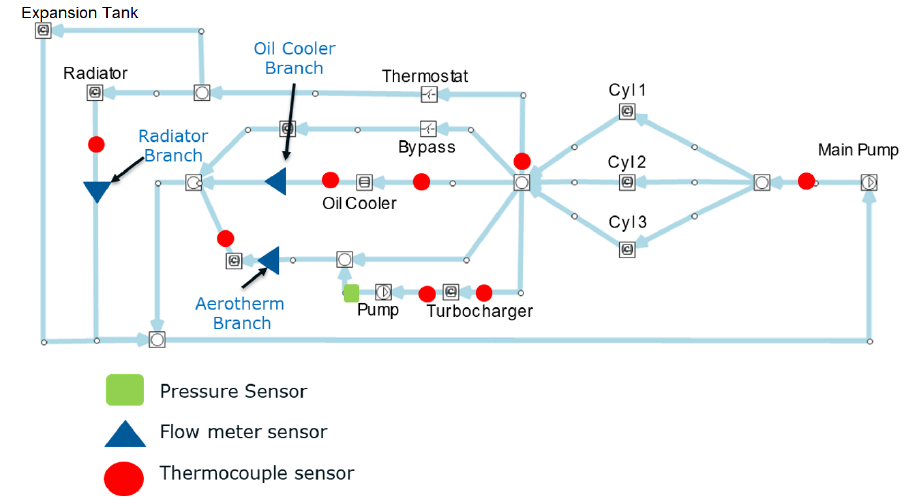
Figure 1. ICE coolant circuit